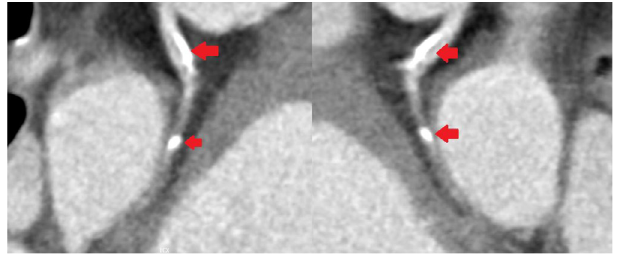
Fig. 3 – Circumflex: presents significant proximal stenosis by mixed lesion. Filled arrows indicate injuries.